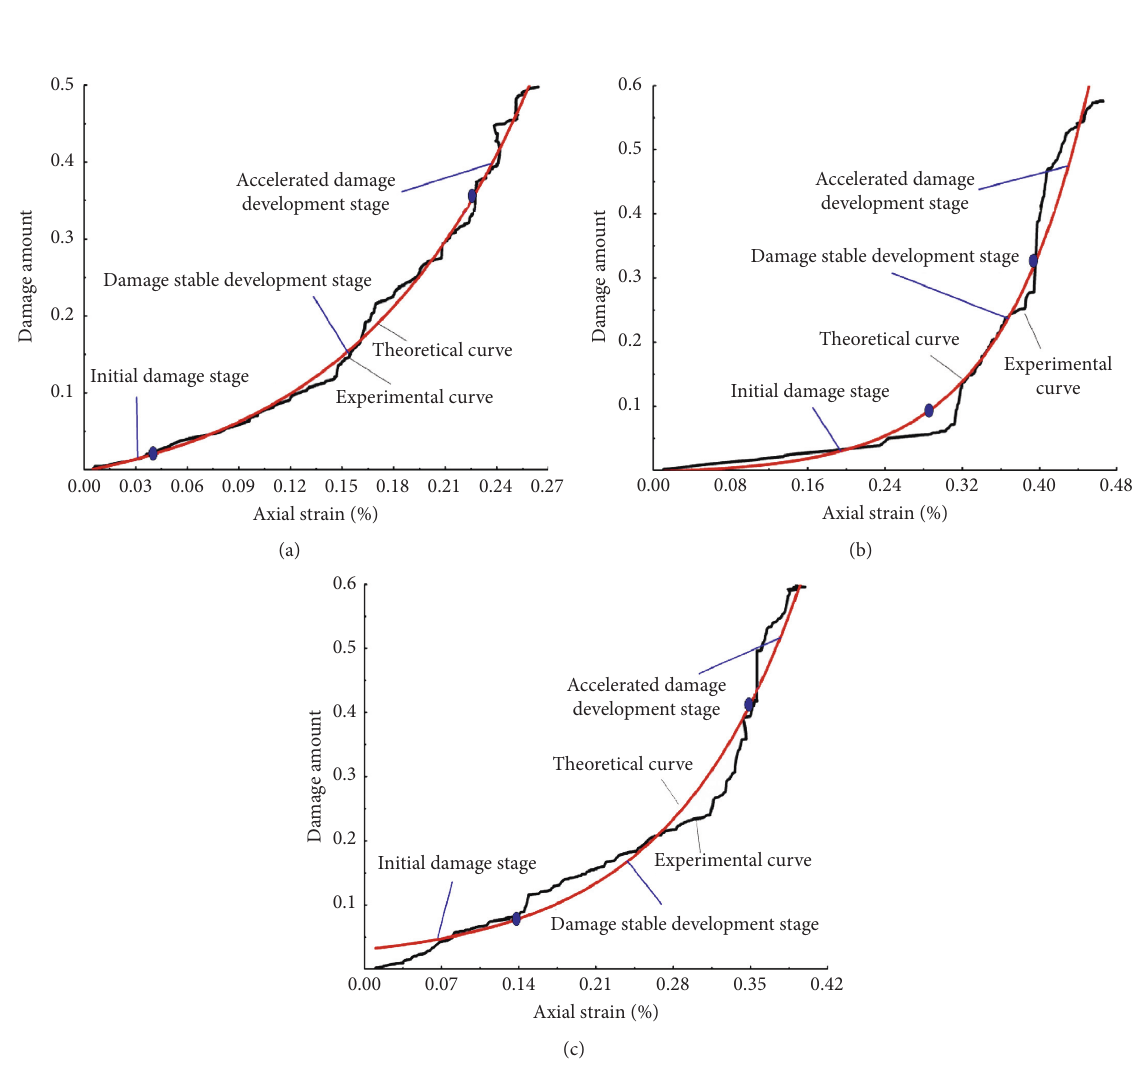
Figure 11: Comparison of theoretical and experimental curves of coal sample damage under different strain rates. (a) 0.005%/min strain rate. (b) 0.02%/min strain rate. (c) 0.03%/min strain